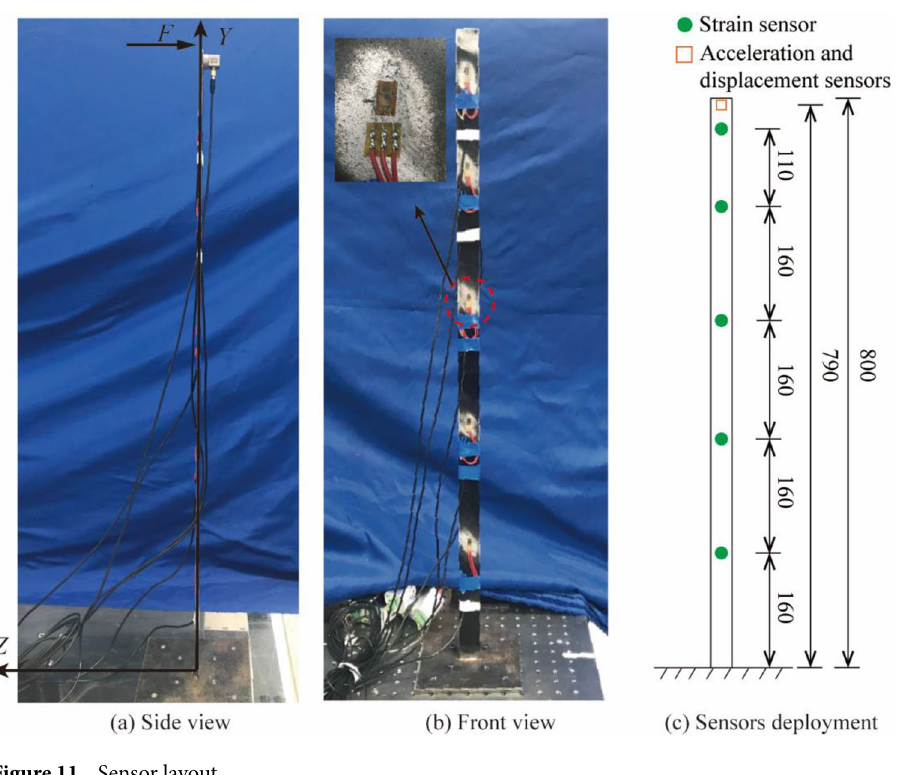
Figure 11. Sensor